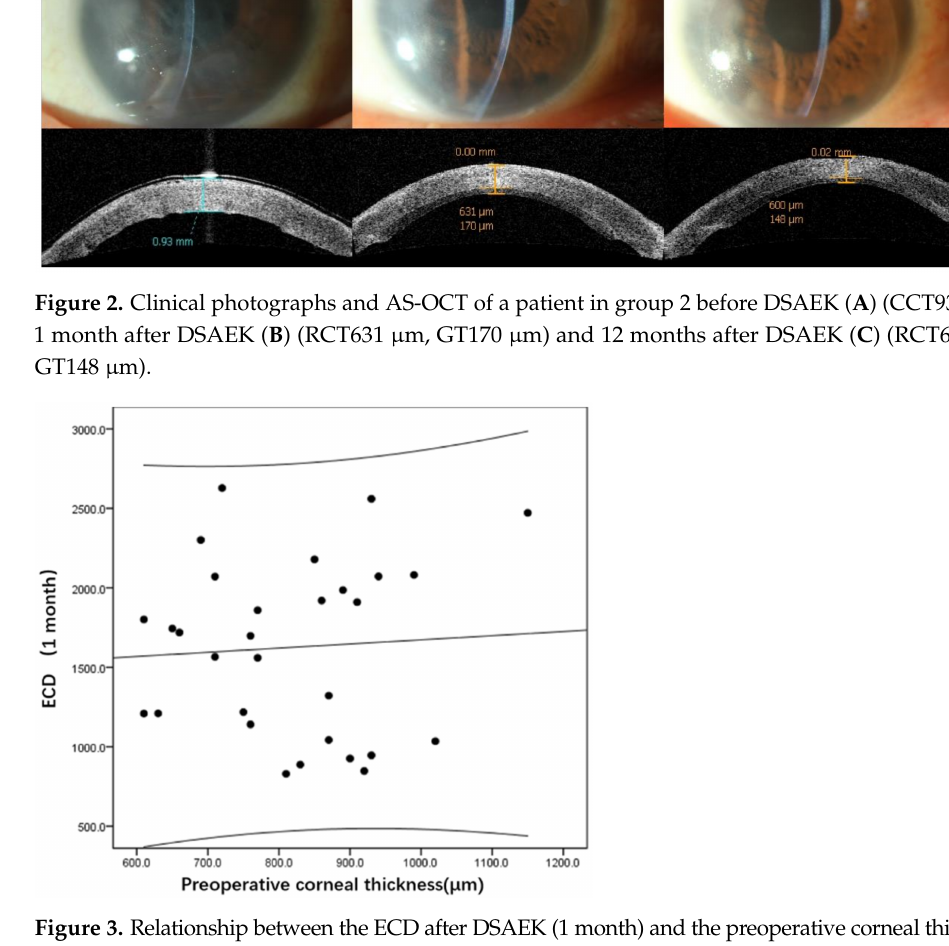
Figure 3. Relationship between the ECD after DSAEK (1 month) and the preoperative corneal thickness.